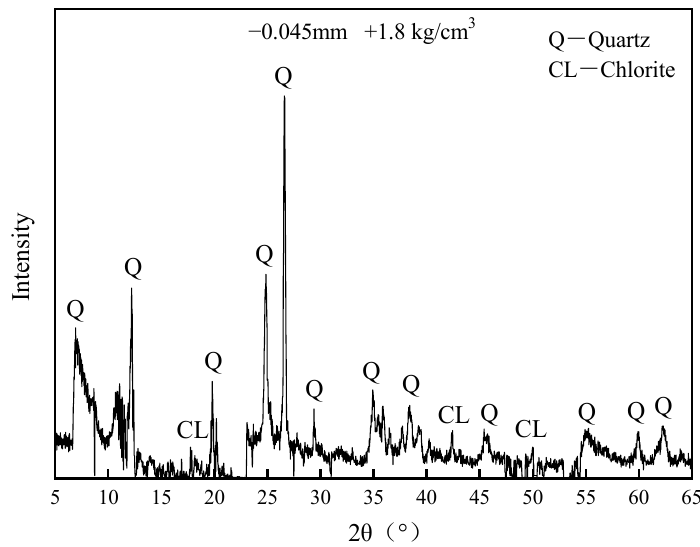
Figure 6. Major mineral composition of mineral-enrichment area.